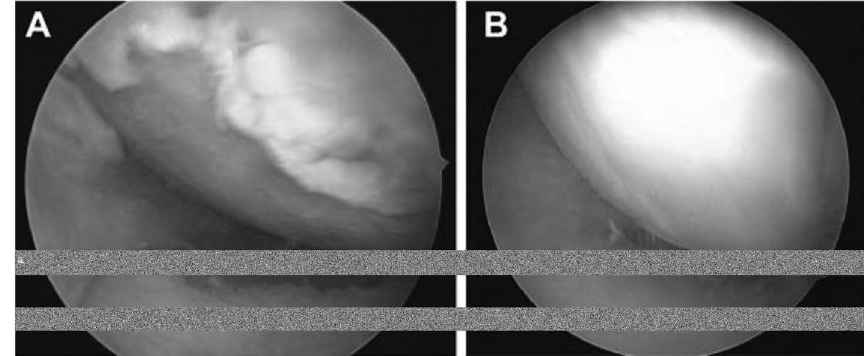
Figure 3. Medial compartment articular cartilage. (A) Before surgery and (B) after